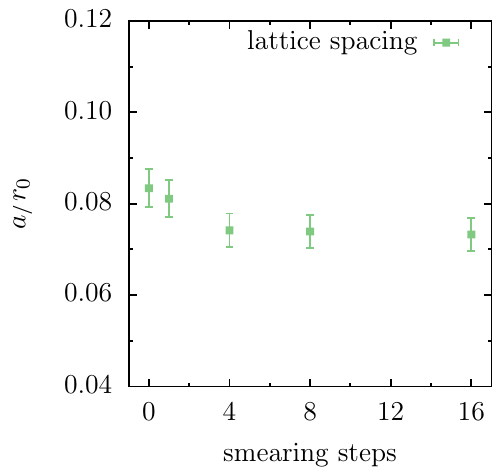
Figure 2 . Dimensionless lattice spacing a/r 0 vs. gauge smearing steps. The values include an extrapolation to the critical point at m crit . To this end the parameter set (II) is fitted to V ( R ) for different m , see table 6 in section B. As long as only a few gauge smearing steps are applied, all values are comparable.